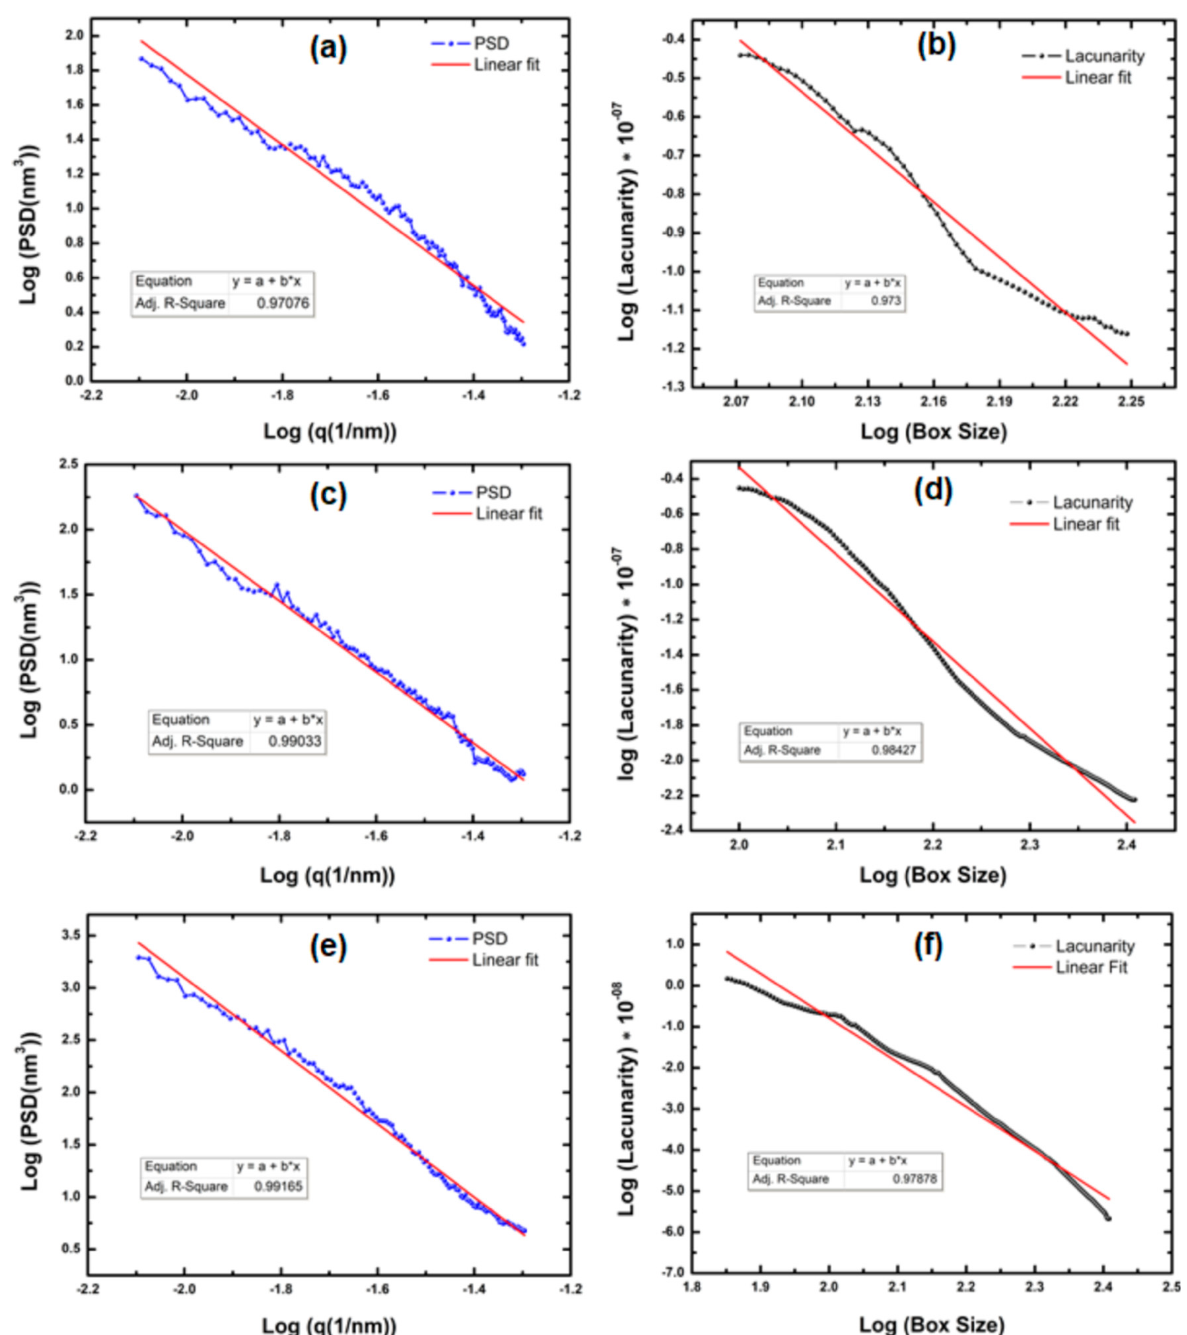
Figure 5. Surface lacunarity and power spectrum density (PSD) of ( a , d ) GdMnO650, ( b , e ) GdMnO750, and ( c , f ) GdMnO850, respectively. Table 5. Fractal and parameters advanced fractals of GdMnO 3 thin films.